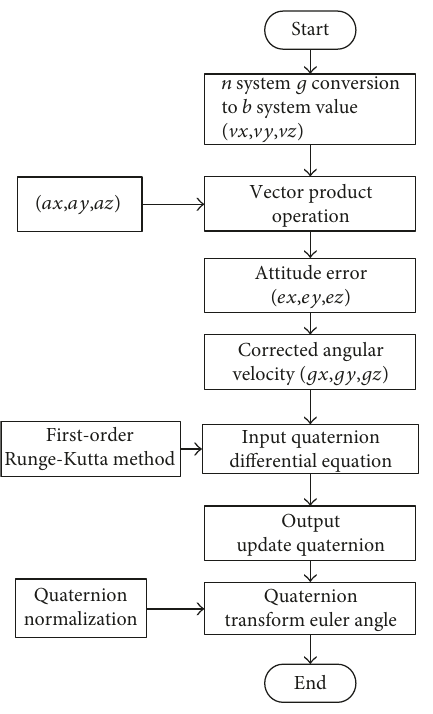
Figure 8: Attitude